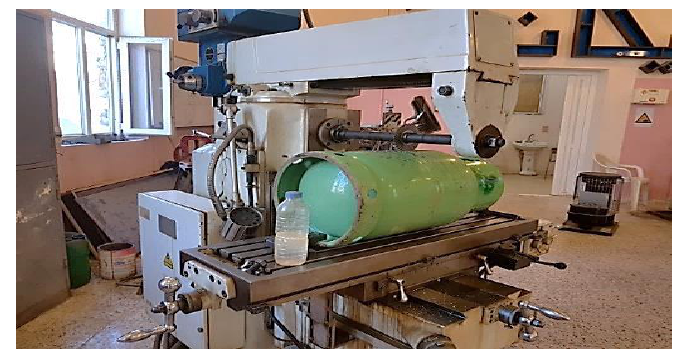
Figure 6: Cutting process of LPG cylinders